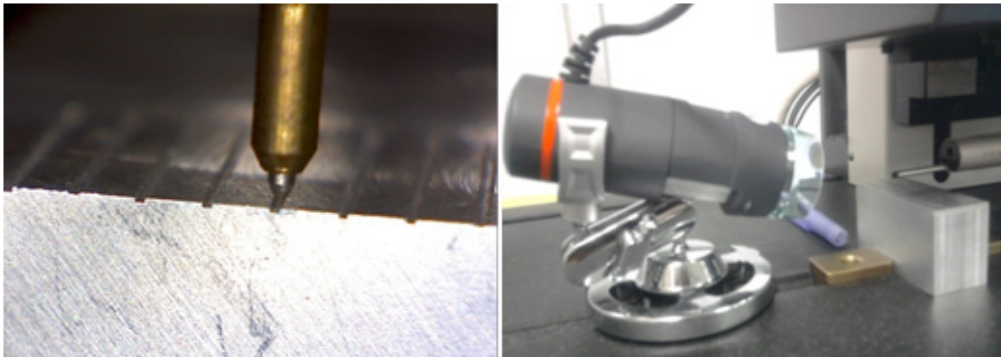
Figure 12. Channel alignment by Celestron portable